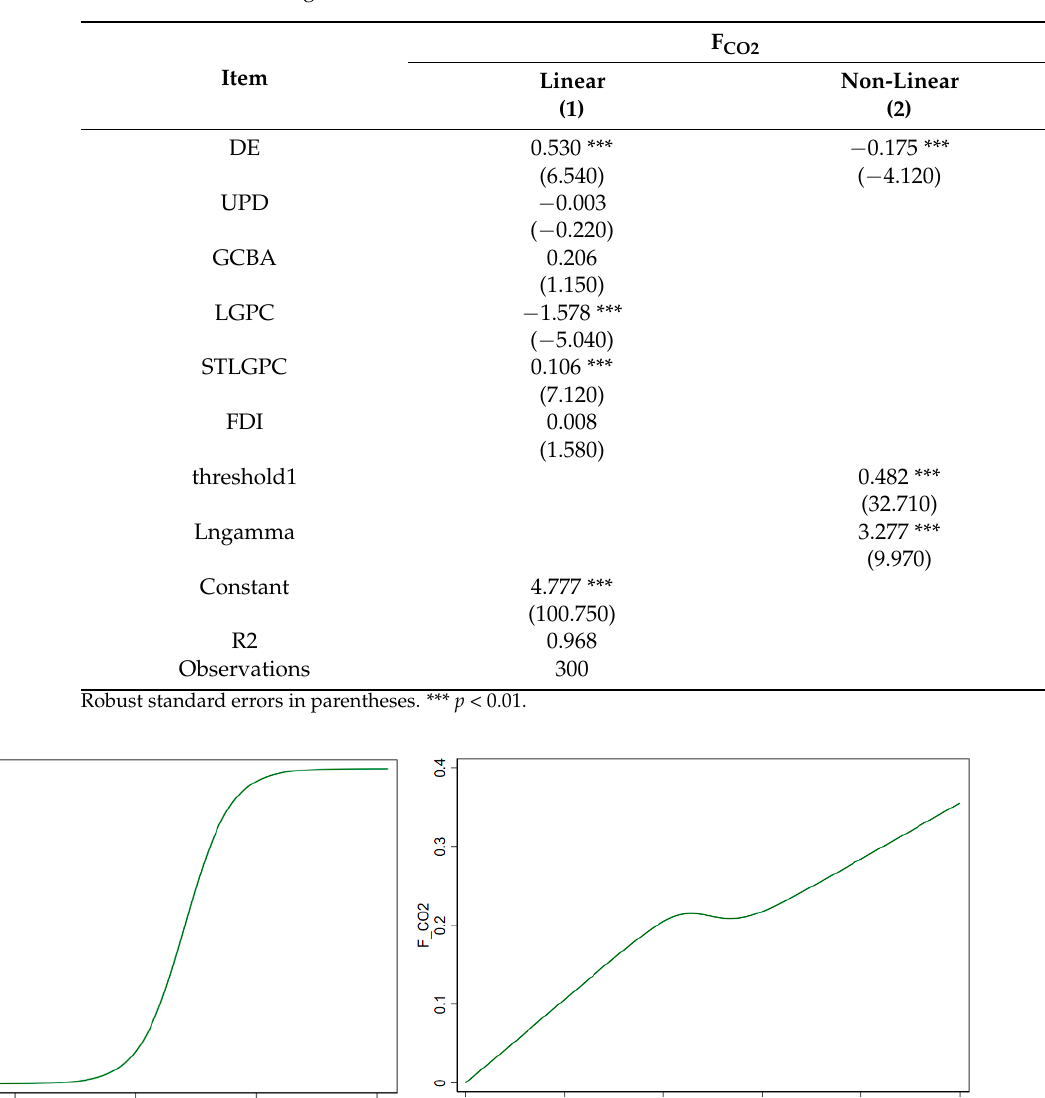
Table 6. Benchmark regression.